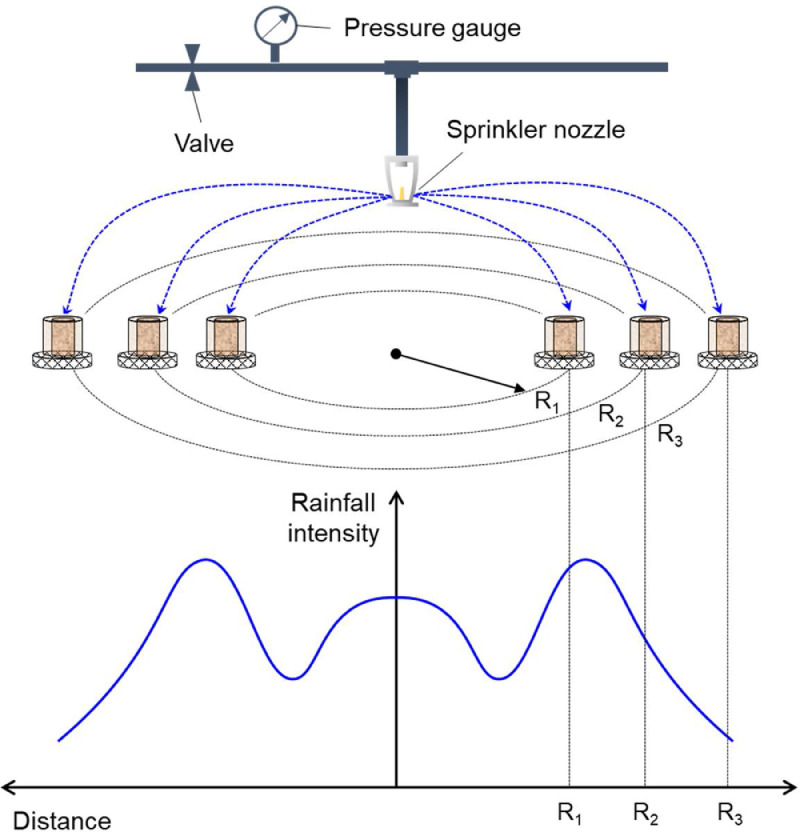
Illustration of water-based suppression simulated by a sprinkler system [1].